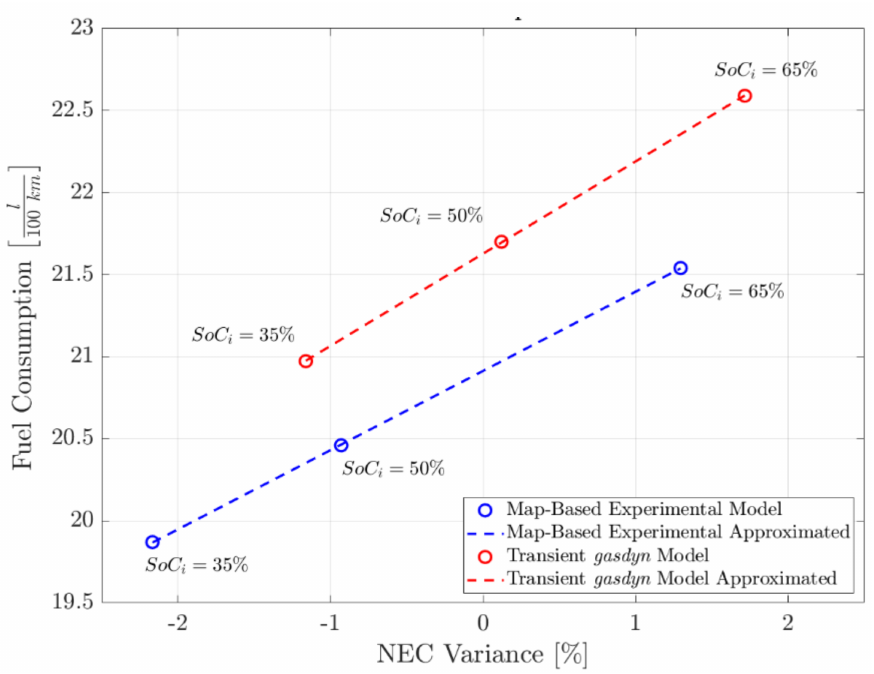
Figure 14. Calculation of WHVC fuel consumption by different models.